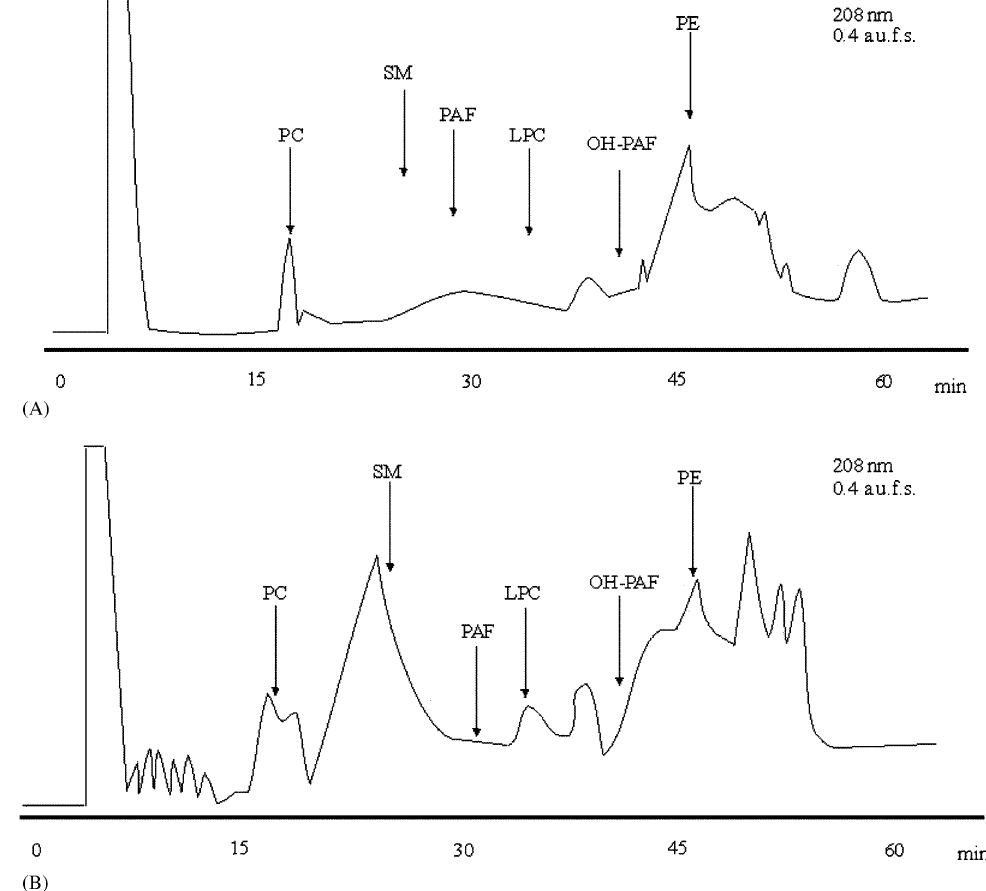
FIG. 1. (A) Representative HPLC separation of polar lipids from periodontal patients blood on a normal-phase NH 2 column. The solvent system consisted of an isocratic elution with 100% solvent A (acetonitrile/methanol, 70:30) for 35 min followed by a linear gradient to 100% solvent B (methanol) for 5 min, a hold for 5 min in 100% solvent B followed by a linear gradient to 100% solvent C (water) for 5 min, and finally a hold in 100% solvent C for 10 min. The eluted substances were detected using ultraviolet detection at 208 nm. (B) Representative HPLC separation of polar lipids from healthy volunteers blood. HPLC conditions were the same as already described. PE, phosphatidylethanolamine; PC, phosphatidylcholine; SM, sphingomyelin; LPC, lysophosphatidylcholine; OH-PAF, hydroxyl-PAF; a.u.f.s., absorption units full